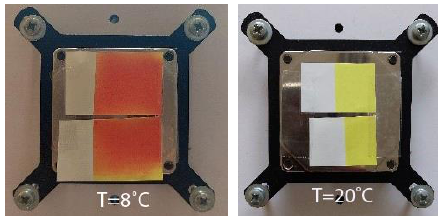
Figure 1. Visual presentation of thermochromic prints obtained on different paper substrates of cold activated OY-12 ink under (8 °C) and above (20 ° C) ink’s T A .